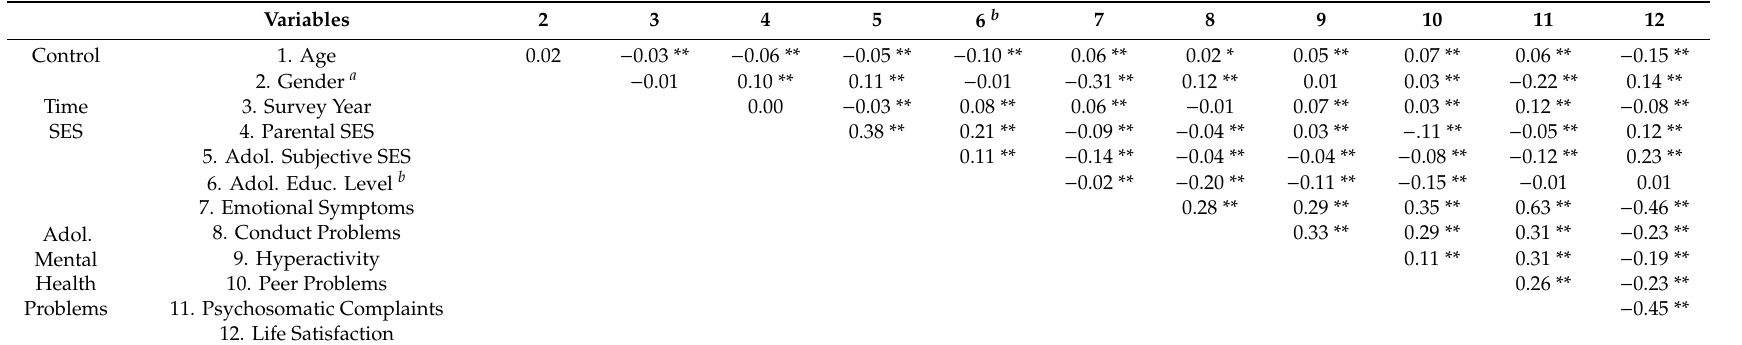
Table 2. Correlations between